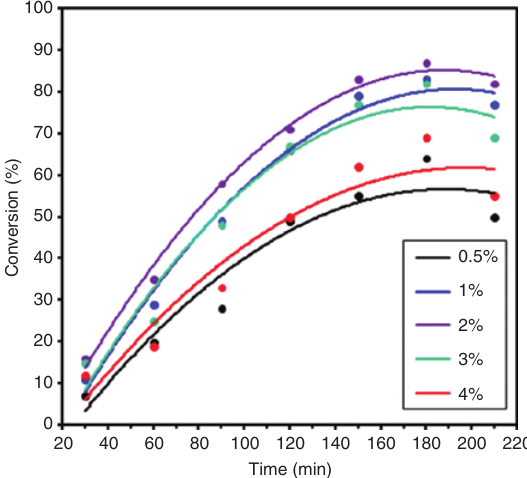
Figure 6: Effect of Maghnite-H + /tetraphenyltetramethylcyclotetrasi- loxane (D 4Ph,Me ) weight ratio on the conversion of monomer.